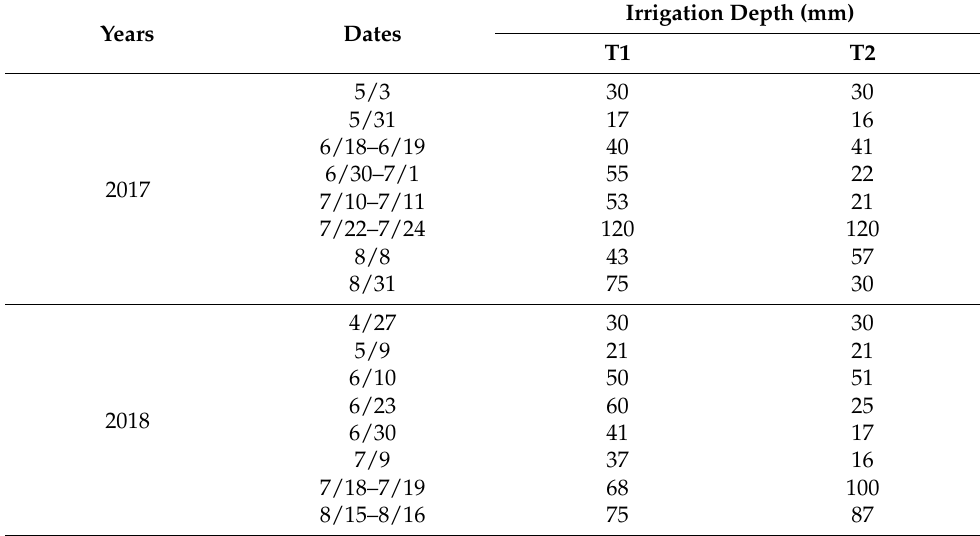
Table 1. Irrigation scheduling for maize with drip irrigation under mulch for two water treatments (T1 and T2) during the whole growth period of maize in 2017 and 2018.